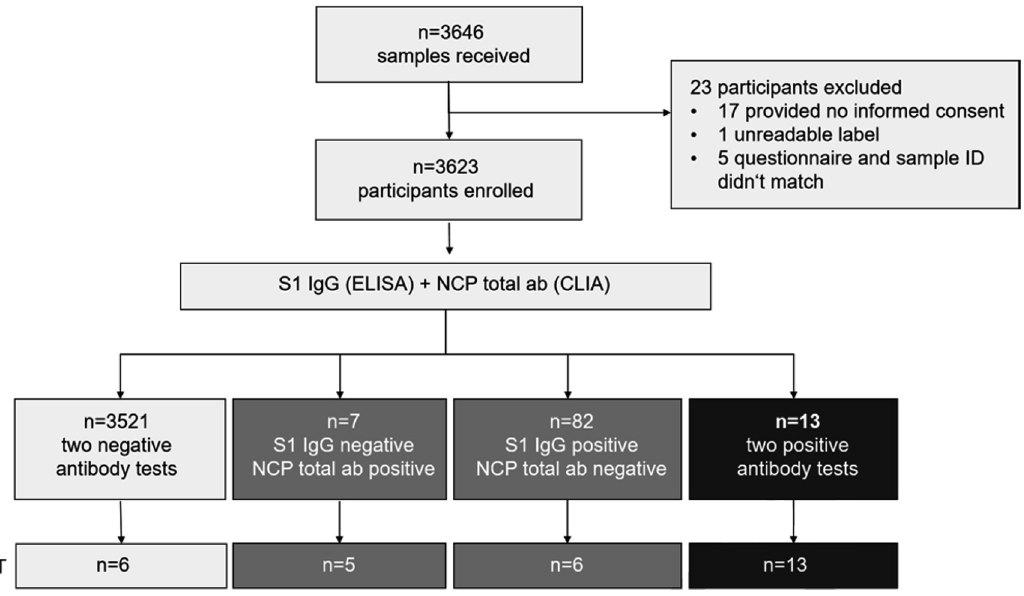
Figure 1: Study design. From3,646subjectssubmittingsamplesforthestudy,23wereexcluded(17withoutinformedconsent,oneunreadablesamplelabel,fivehadno questionnaire).Intotal,3,623participantswereenrolled.AllsamplesweretestedforspikeproteinsubunitS1-specificIgGbyAnti-SARS-CoV-2S1 IgGELISA (Euroimmun)andfor nucleoprotein(NCP)-specifictotal antibodies by Anti-SARS-CoV-2CLIA (Roche).Theindicated